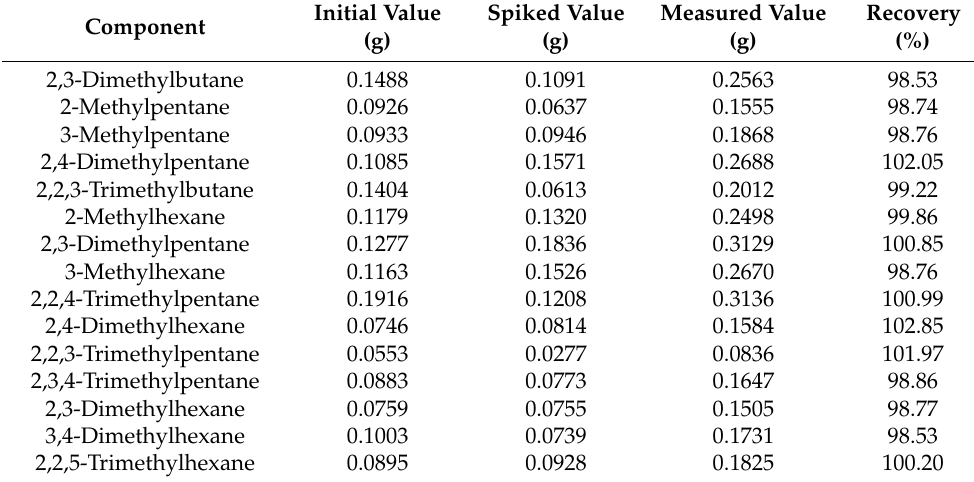
Table 4. Determination results of the